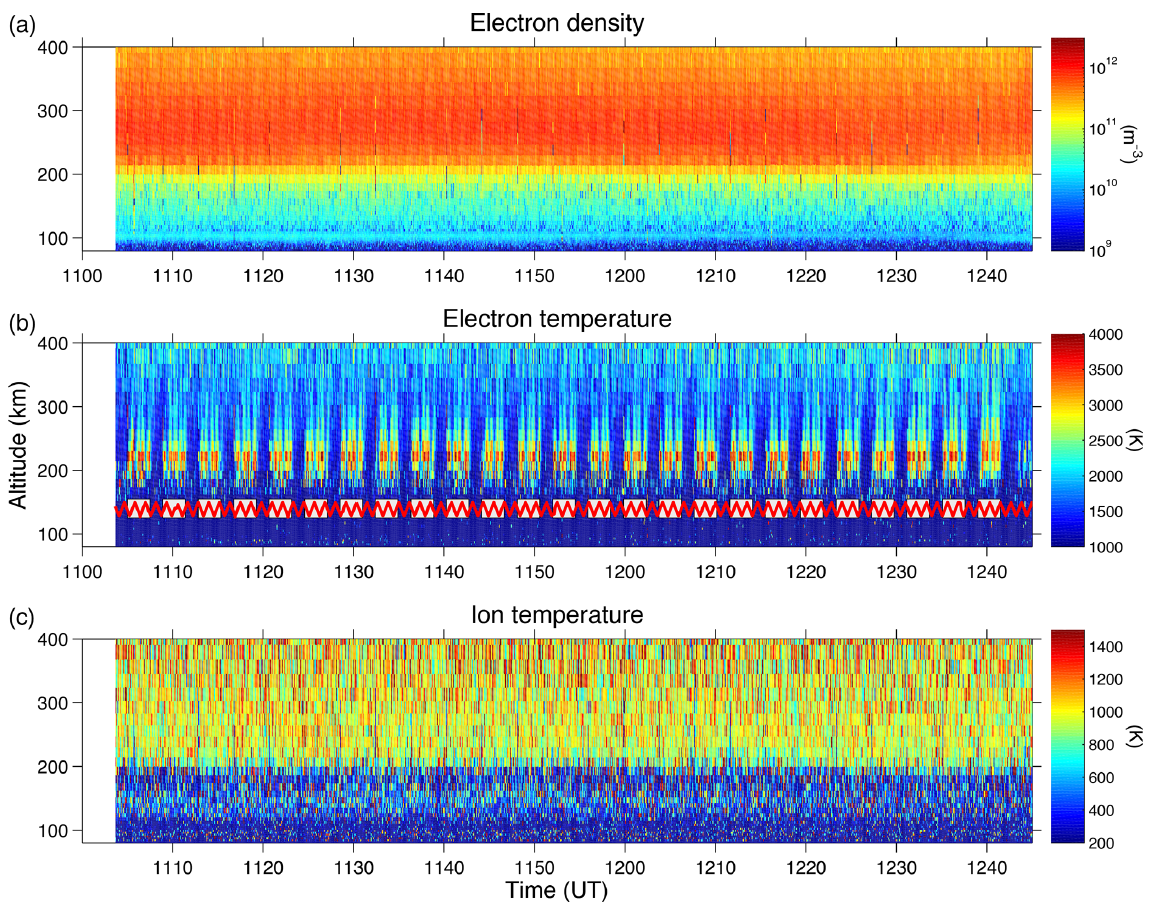
Figure 1. Height profiles as a function of time of (cid:102) N e (a) , (cid:101) T e (b) and (cid:101) T i (c) during pump cycling on 25 November 2014. The white boxes in (b) show pump-on and the red zigzag line indicates the elevation of the UHF radar which was scanned between 75.2 and 82.2 ◦ in 1.0 ◦